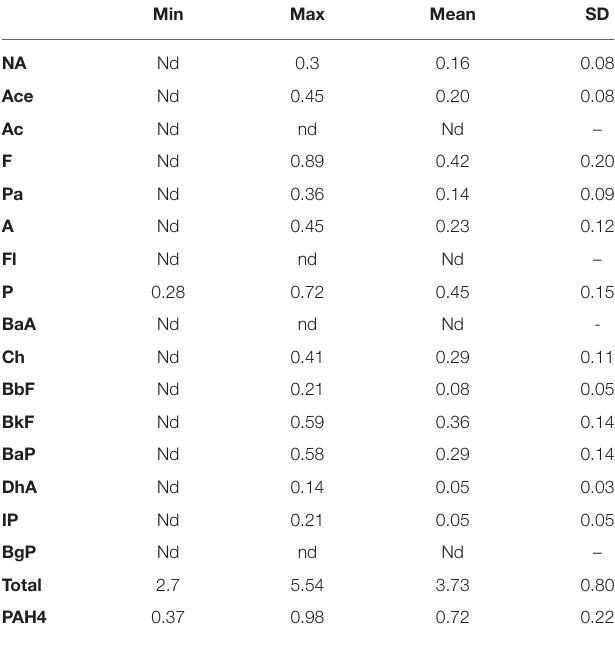
TABLE 4 | Statistical analysis of PAHs in baby food samples ( µ